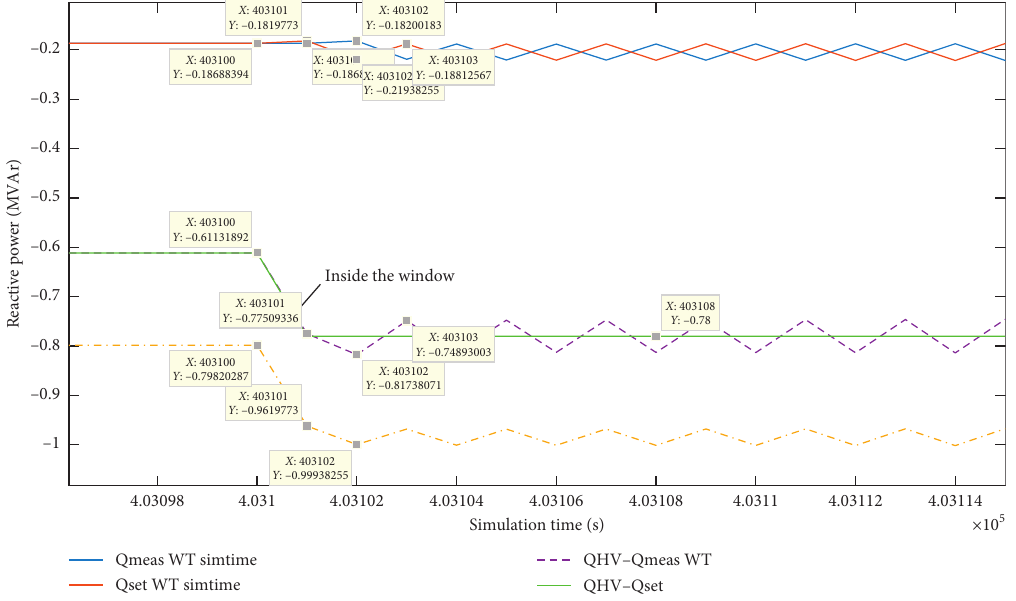
Figure 9: Oscillation investigation when T